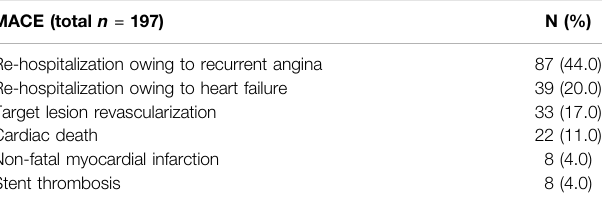
TABLE 5 | Major adverse cardiovascular events (MACE) in ACS patients during hospitalization and the 25-months follow-up period after discharge.